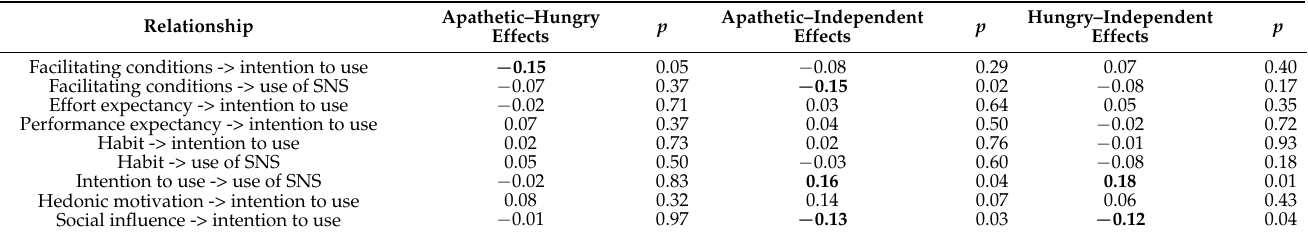
Table 6. PLS-MGA